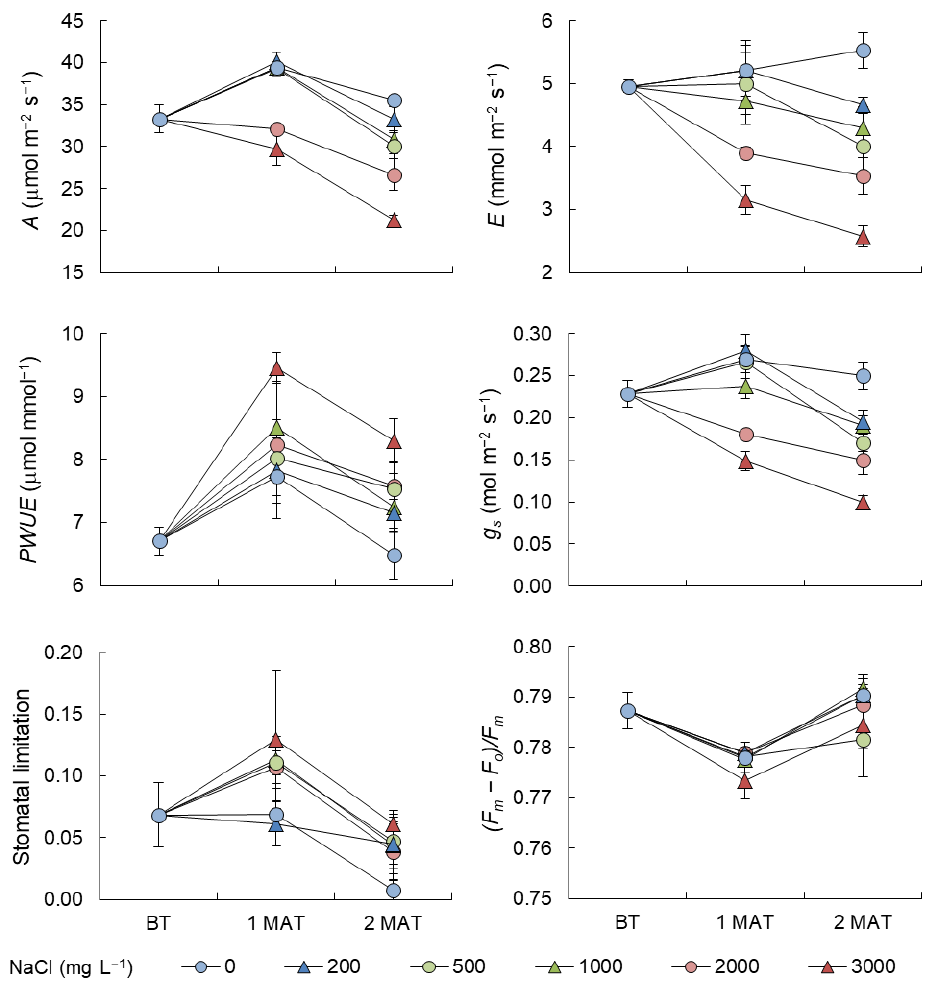
Figure 2. Changes in photosynthetic parameters at each stage (before treatment, BT; one month after treatment, 1 MAT; 2 months after treatment, 2 MAT) in Exp. 1. Bars represent SE of the means ( n = 4). Figure 3 illustrates the relationship between g s ranging from 0.08 to 0.32 mol m −2 s −1 , and A ranging from 19.2 to 43.2 µ mol m −2 s −1 . Irrespective of the growth stages, these two parameters were highly positively correlated, and the relationship for the overall samples was significant at the 0.1% level with a correlation coefficient ( r ) of 0.898.